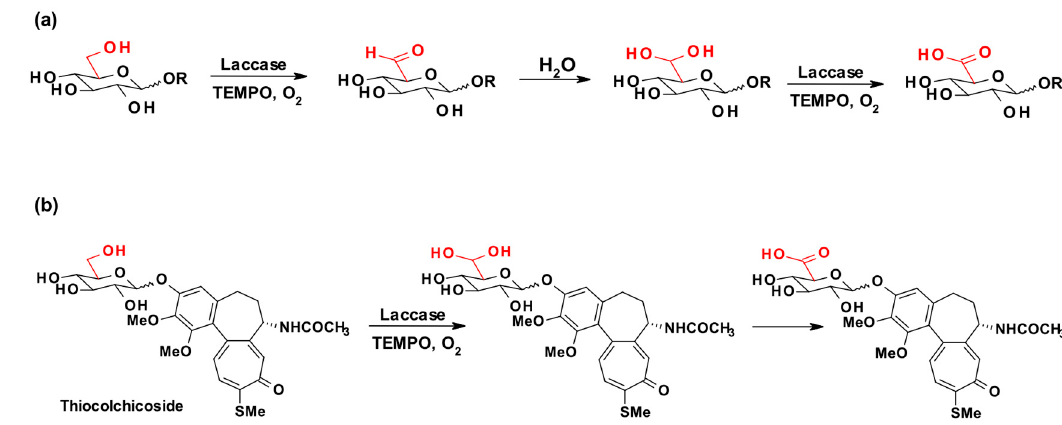
Figure 1. Examples of chemical mediators employed in laccase-mediator system (LMS). ( a ) 3-Hy- droxyanthranilic acid (HAA); ( b ) 2,20-azino-bis-(3-ethylbenzothiazoline-6-sulphonic acid) (ABTS); ( c ) 2,2,6,6-tetramethyl piperidine-1-yloxy (TEMPO); ( d ) N -hydroxybenzo-triazole (HBT); ( e ) vio- luric acid (VLA); ( f ) methyl ester of 4-hydroxy-3,5-dimethoxy-benzoic acid (syringic